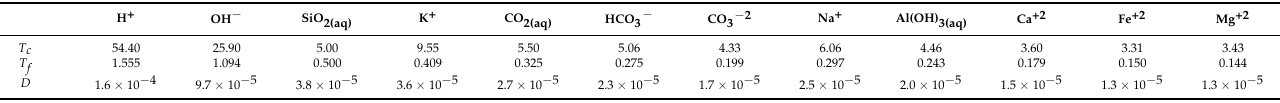
Table 2. The model parameters and diffusion coefficient values D computed at T = 65 ◦ C using the model of Boudreau